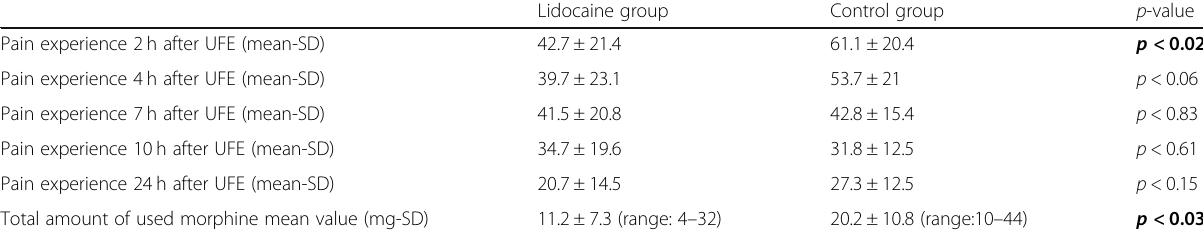
Table 2 The pain experience and used of morphine -comparison between the groups